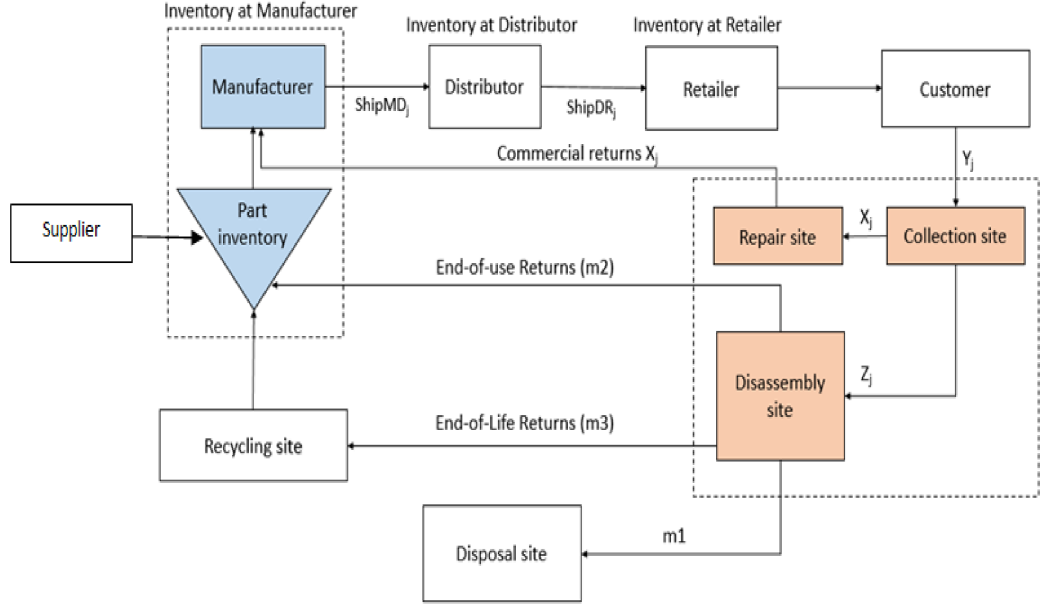
Figure 1. Proposed framework of